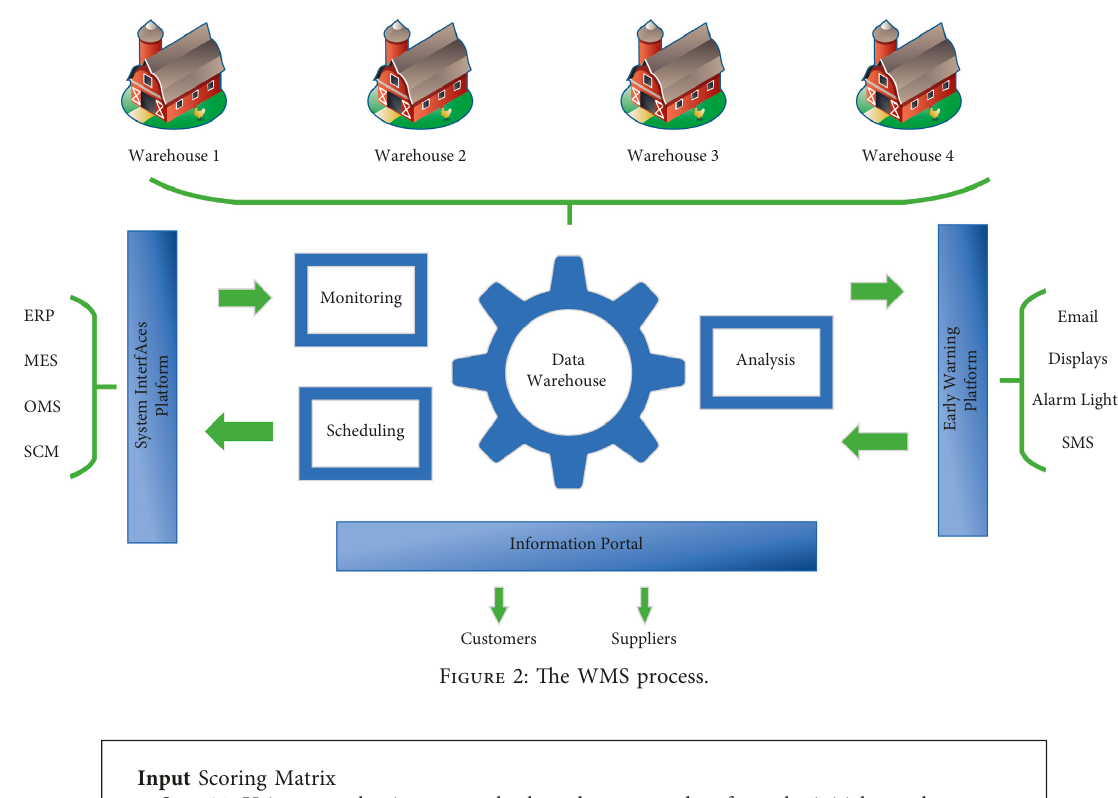
Figure 2: The WMS